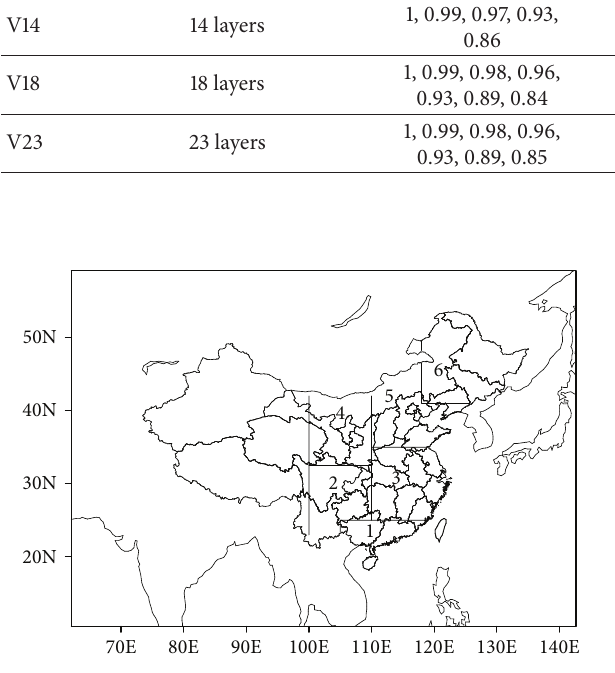
Figure 1: Model domain and distribution of the studied subareas, where subareas 1–6 correspond to South China, Southwest China, East China, Northwest China, North China, and Northeast China,